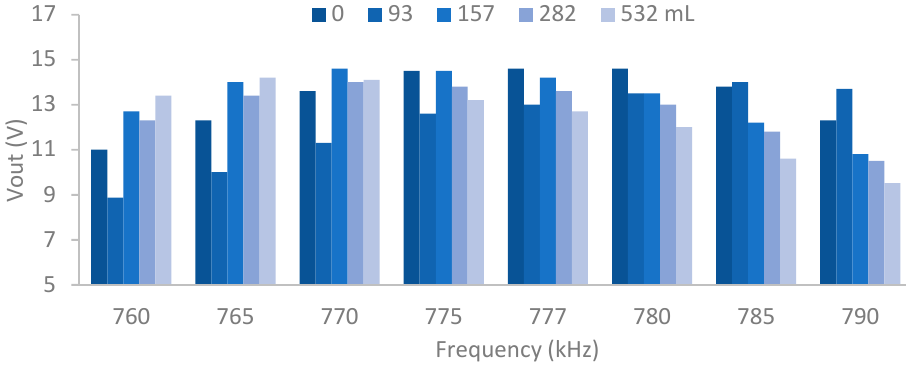
Figure 9. Vout of P8 using samples with different water content.